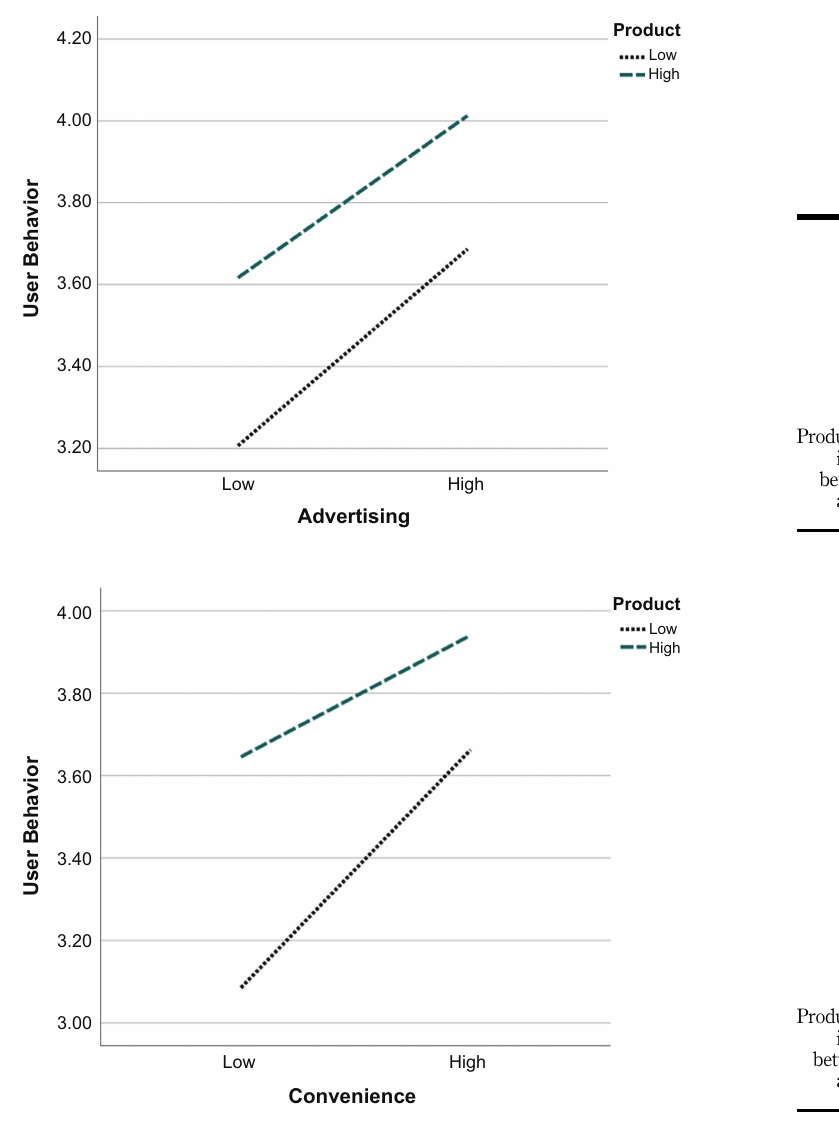
Figure 5. Product as a moderator in the relationship between convenience and user behavior